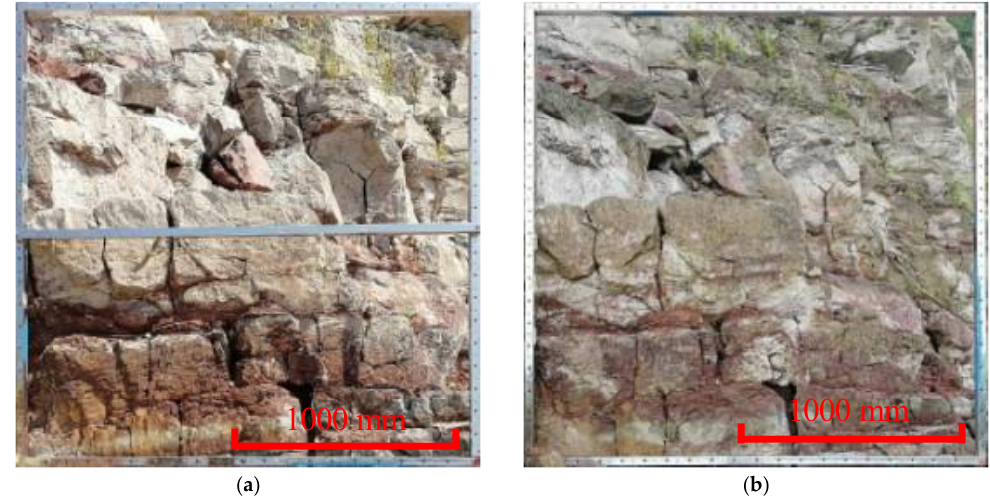
Figure 8. In situ pictures of measured area (2 m × 2 m). ( a ) Site picture of the measuring area (17 August 2019). ( b ) Site picture of the measuring area (12 July 2020).